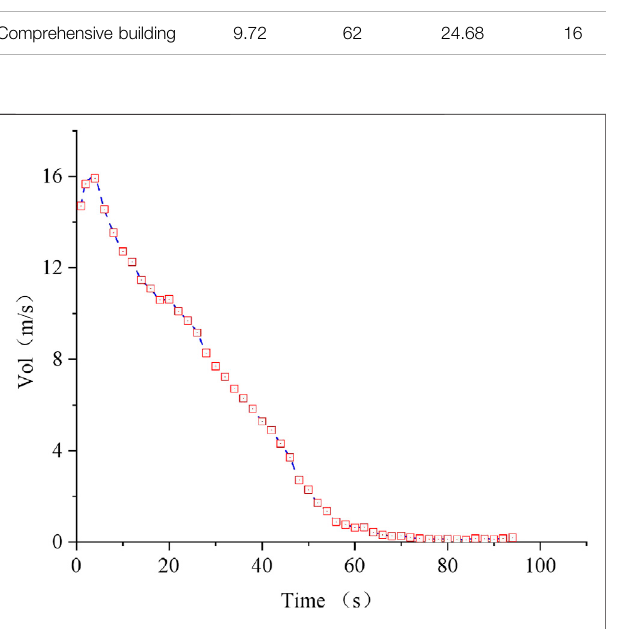
FIGURE 9 | Change in sediment velocity at the bottom of the tailings dam.